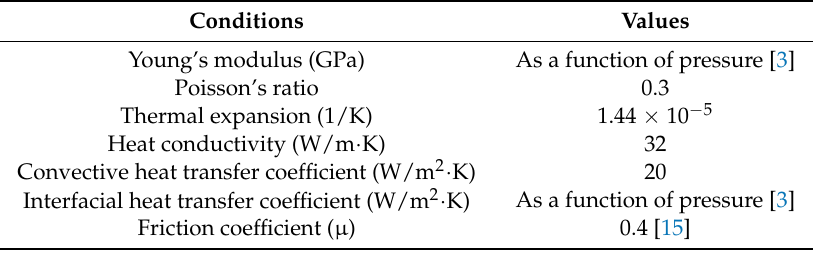
Table 5. Material constants of boron steel in the